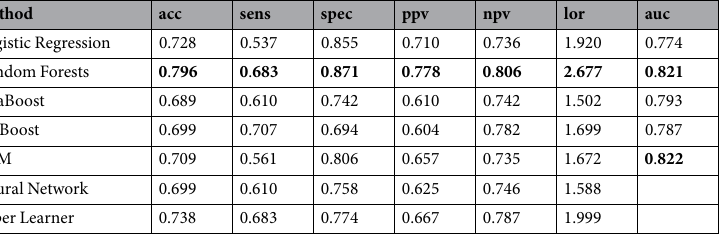
Table 13. Performance of model-based and model-free methods (using top 10 selected features).